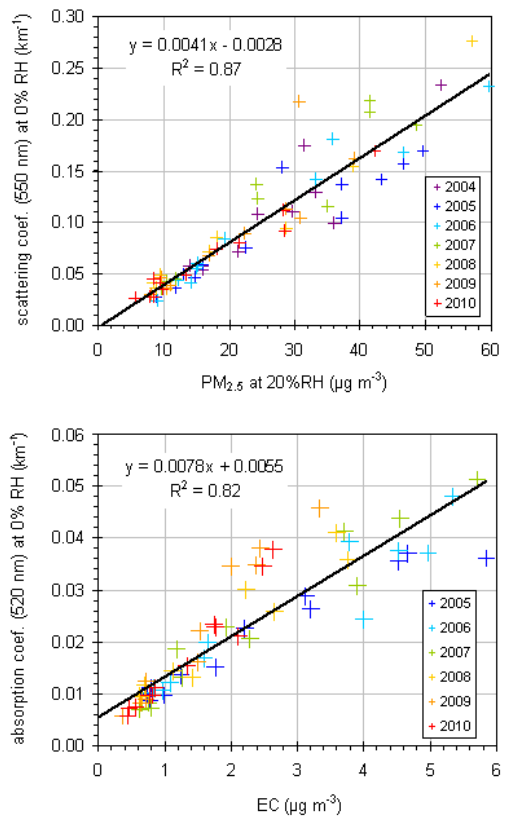
Figure 7. Regressions between monthly averages of (a) the aerosol scattering coefficient and PM 2 . 5 mass concentration, and (b) the aerosol absorption coefficient and EC mass concentration.